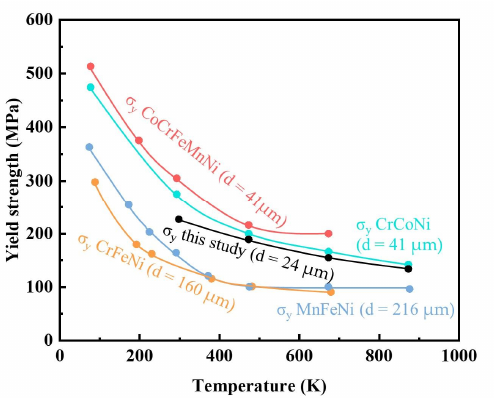
Figure 8. Temperature dependence of the yield stress of Ni 2 CrFe alloys and compared with other